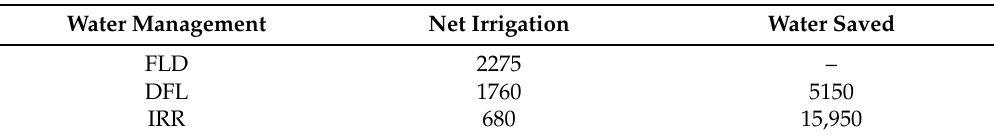
Table 1. Irrigation and water saving amounts of different water regimes. Both the elements are expressed in mm.